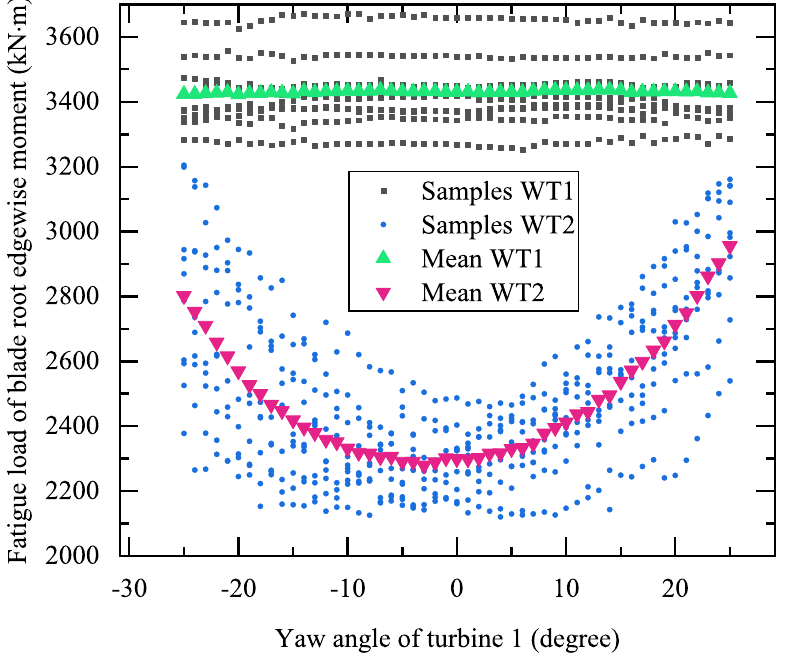
Figure 8. DEL-BREM’s samples data and mean value in each yaw angle